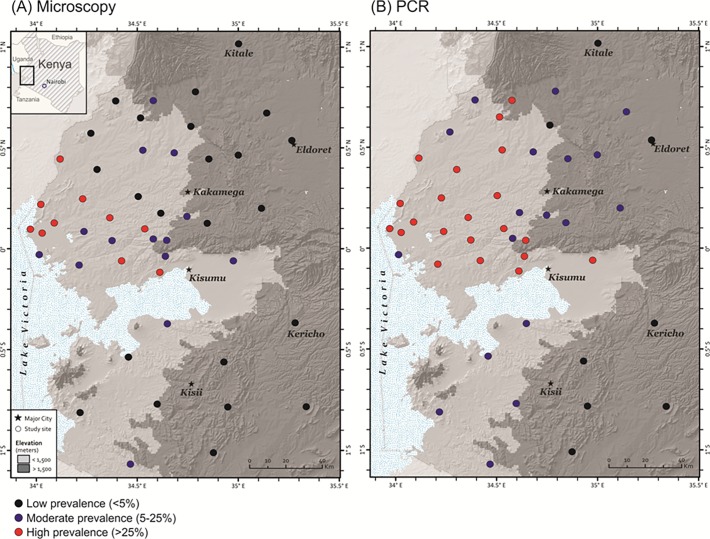
Malaria prevalence of studied sites in western Kenya based on (A) microscopy and (B) conventional PCR.Locality information can be referred to S1 Table. Areas of elevation below 1500 m were indicated by light gray and above 1500 m by dark gray. Black, blue, and red circles represent sites of low (<5%), moderate (5–25%), and high (>25%) malaria prevalence.